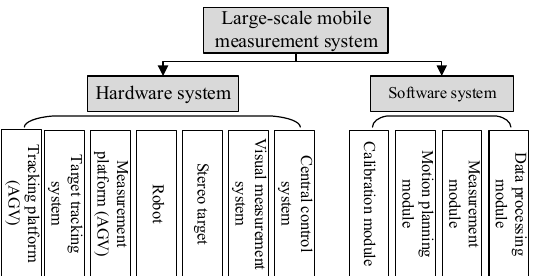
Figure 1. Schematic diagram of the structure of the large-scale mobile measurement system.